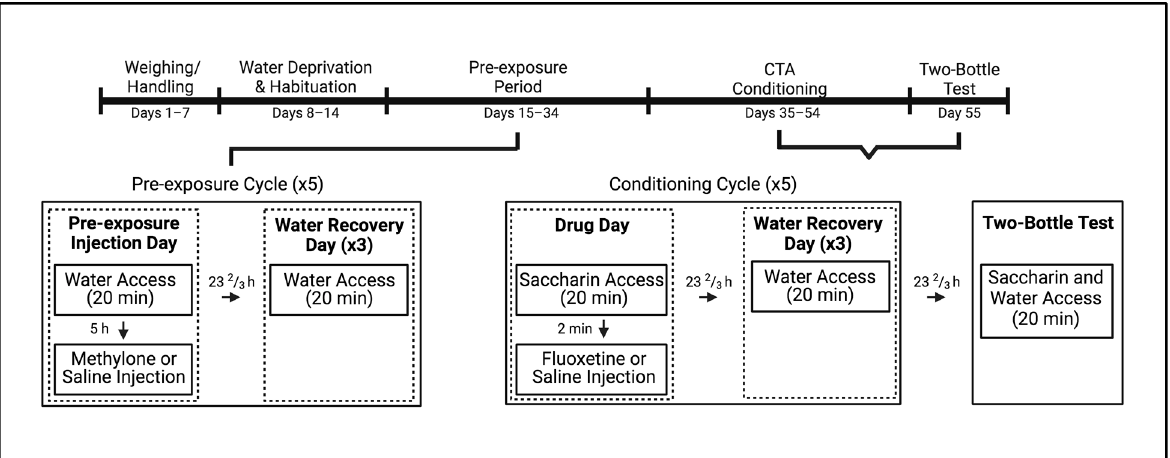
Figure 1. Experimental timeline for subjects pre-exposed to methylone or saline prior to undergoing taste avoidance conditioning with fluoxetine or saline. Created with BioRender.com.